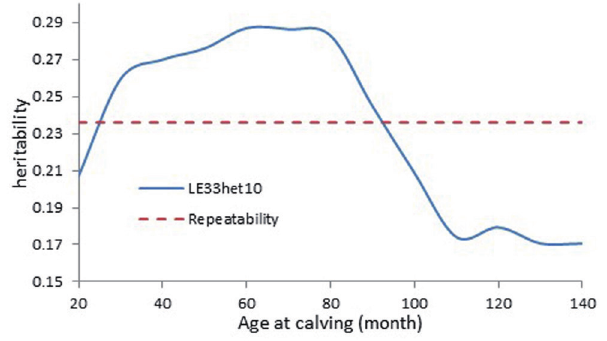
Figure 2. Heritability estimates for total milk yield obtained with repeatability and LE33het10